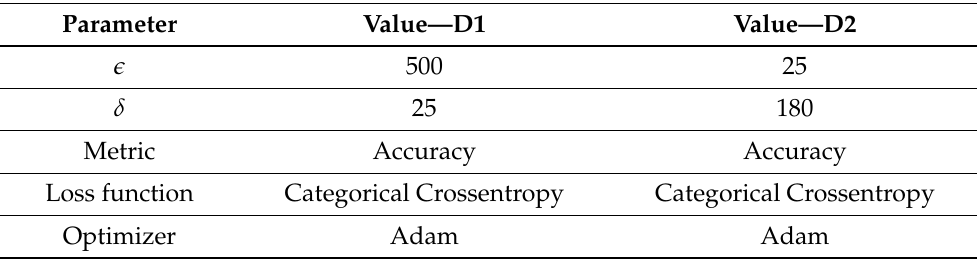
Table 4. Parameters for the